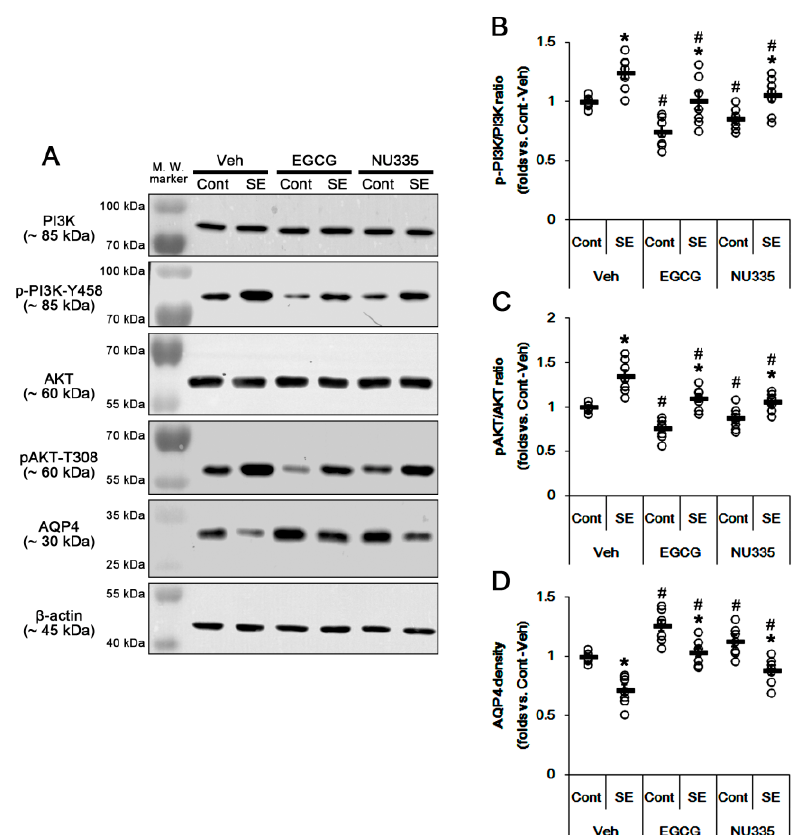
Figure 6. Effects of EGCG and NU335 on phosphatidylinositol 3 kinase (PI3K)/AKT activities and aquaporin 4 (AQP4) expression level in the PC under physiological and post-SE conditions. SE increases PI3K / AKT activities, but it decreases the AQP4 protein level in the PC. EGCG and NU335 decrease PI3K / AKT activities under physiological and post-SE conditions. ( A ) Representative Western blot images for PI3K, p-PI3K, AKT, AKT, and AQP4 in the PC. ( B – D ) Quantitative values of the e ff ect of EGCG and NU335 on p-p38 MAPK ( B ), pAKT and AQP4 levels in the PC ( n = 7, respectively). Open circles indicate each individual value. Horizontal bars indicate mean value. Error bars indicate S.E.M. Significant di ff erences are * ,# p < 0.05 vs. control (non-SE) animals and vehicle-treated animals, respectively.